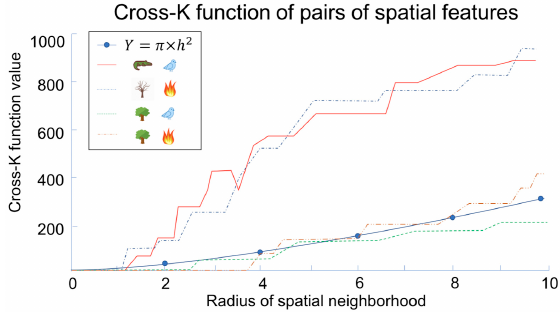
Figure 2. A spatial dataset.